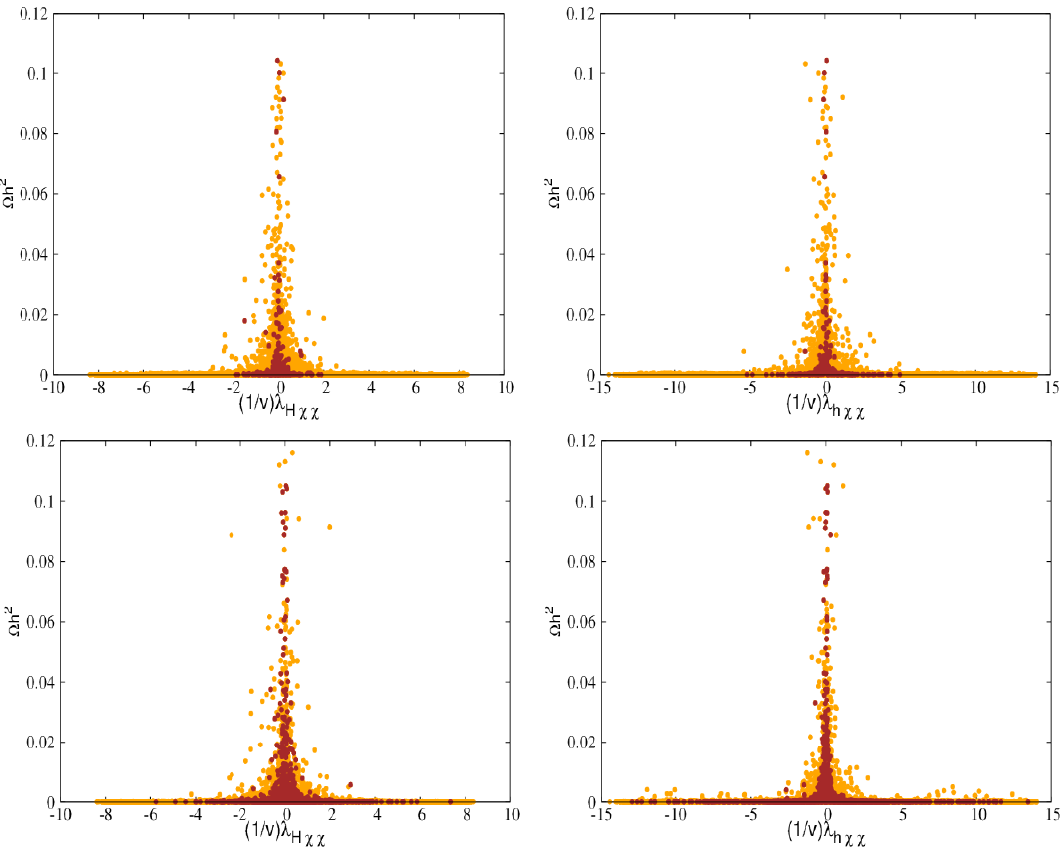
Figure 2 . Dependence of relic density on λ ochre regions satisfy relic density constraints. The maroon points satisfy direct detection constraints as